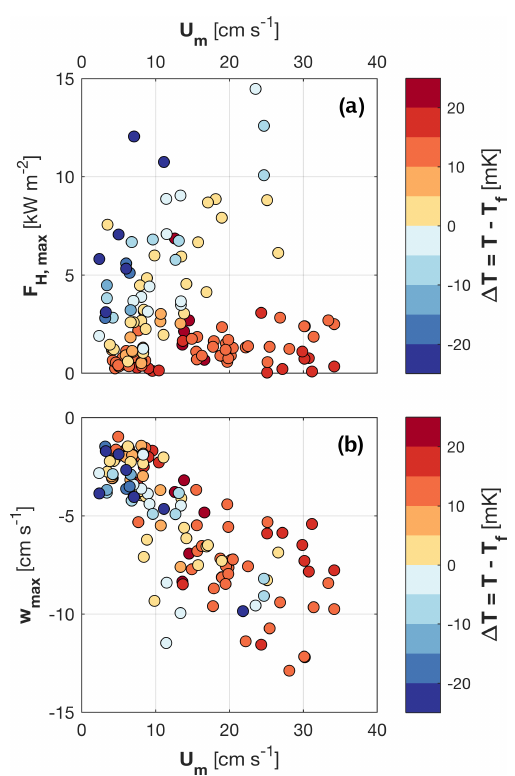
Figure 6. Mean horizontal current ( U m ) vs. instantaneous (a) max- imum heat flux and (b) minimum vertical current speed. Circles are color coded for temperature above freezing ( (cid:49)T = T − T f ), cal- culated using mean absolute salinity and conservative temperature (McDougall and Barker, 2011). Mean values are calculated over the 14s surrounding the peak vertical current speed of each identified